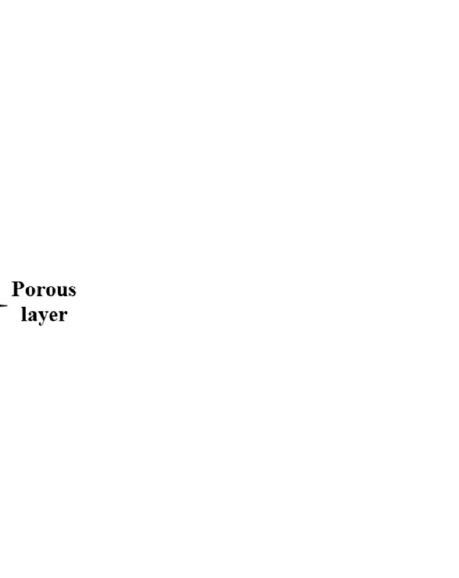
Figure 5. Schematic representation of the structure of the anodized layer. Reprinted from Ref. [54]. The appearance of microscale pores in the anodized layer can significantly worsen its corrosion and electrical insulating characteristics. Therefore, their appearance is considered an undesirable sign. Figure 6a shows intermetallics of the Fe(Mn,Cu,Mg) 3 Al type, which did not dissolve in the solid solution during heat treatment of the 1011 aluminum alloy and remained in the structure of the anodized layer. It is these inclusions that contributed to the formation of microscale pores in the hard anodized layer. Figure 6b shows such pores that were formed in the anodized layer under the influence of electrolyte, which eroded the boundaries of intermetallic inclusions Fe(Mn,Cu,Mg) 3 Al with the surrounding layer during its synthesis. As a result of such etching, pores commensurate with intermetallic inclusions were formed in their place. The precipitation of copper at the cathode was considered evidence of such etching during anodization of the surface of the aluminum alloy. However, Fe(Mn,Cu,Mg) 3 Al intermetallides do not usually have time to completely dissolve upon contact with the electrolyte and therefore (as shown in Figure 6c,d) partially remain in the pores of the hard oxidized